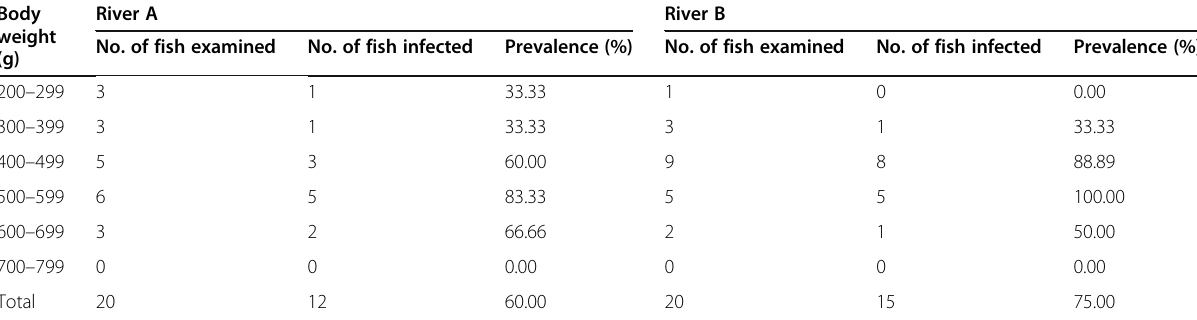
Table 8 Prevalence of parasites in relation to body weight of natural C. gariepinus Body weight